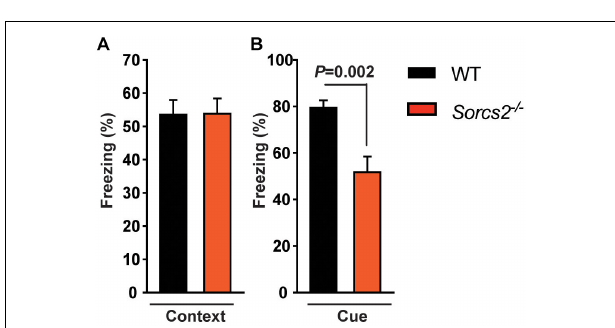
FIGURE 2 | Intact context- but impaired cue-dependent memory in Sorcs2 − / − mice. The time spent freezing in response to context (A) or cue (B) of WT and Sorcs2 − / − mice in a context- and cue-dependent fear conditioning experiment, showing that Sorcs2 − / − mice have intact contextual fear-learning (hippocampus) while cue-dependent memory (amygdala) was significantly reduced compared to WT mice ( P = 0.002) ( n = 21 for WT and n = 18 for Sorcs2 − / −